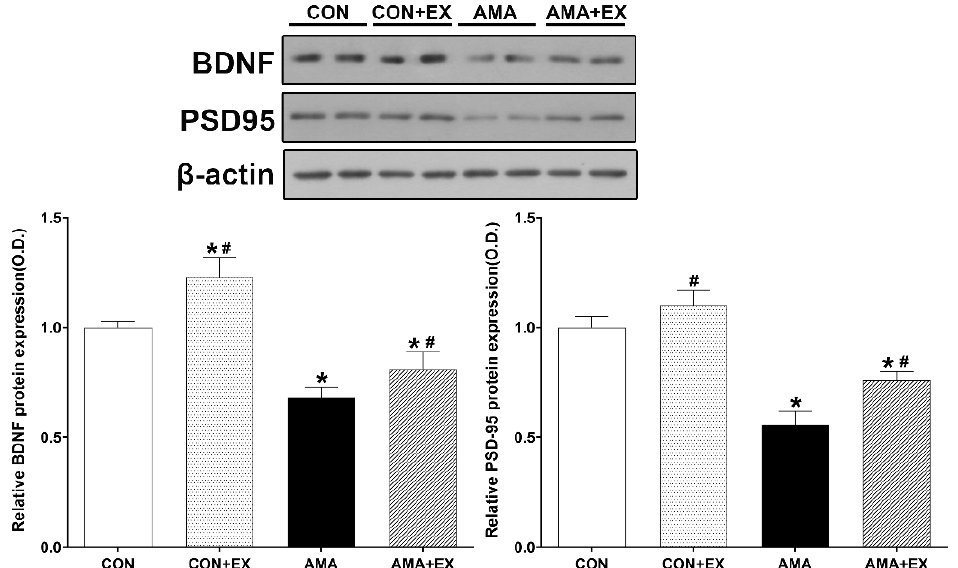
Figure 2. Effects of exercise on BDNF and PSD95 in the hippocampus of the offspring from mothers with advanced maternal age (AMA). CON: offspring from the control group; CON + EX: offspring from the control and exercised group; AMA: offspring from the advanced maternal age group; AMA + EX: offspring from the advanced maternal age and exercised group. Data are expressed as means ± standard error of the mean (SEM). * p < 0 . 05 compared to the CON group. # p < 0 . 05 compared to the AMA group.